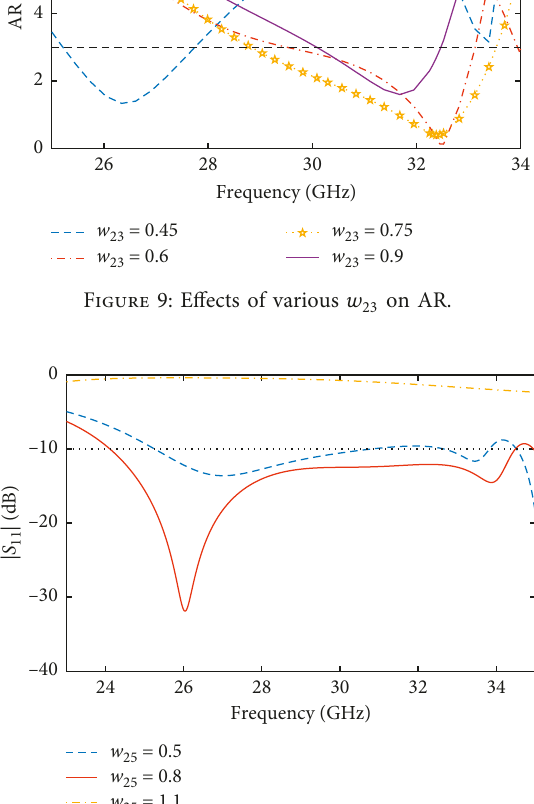
Figure 10: Effects of various w